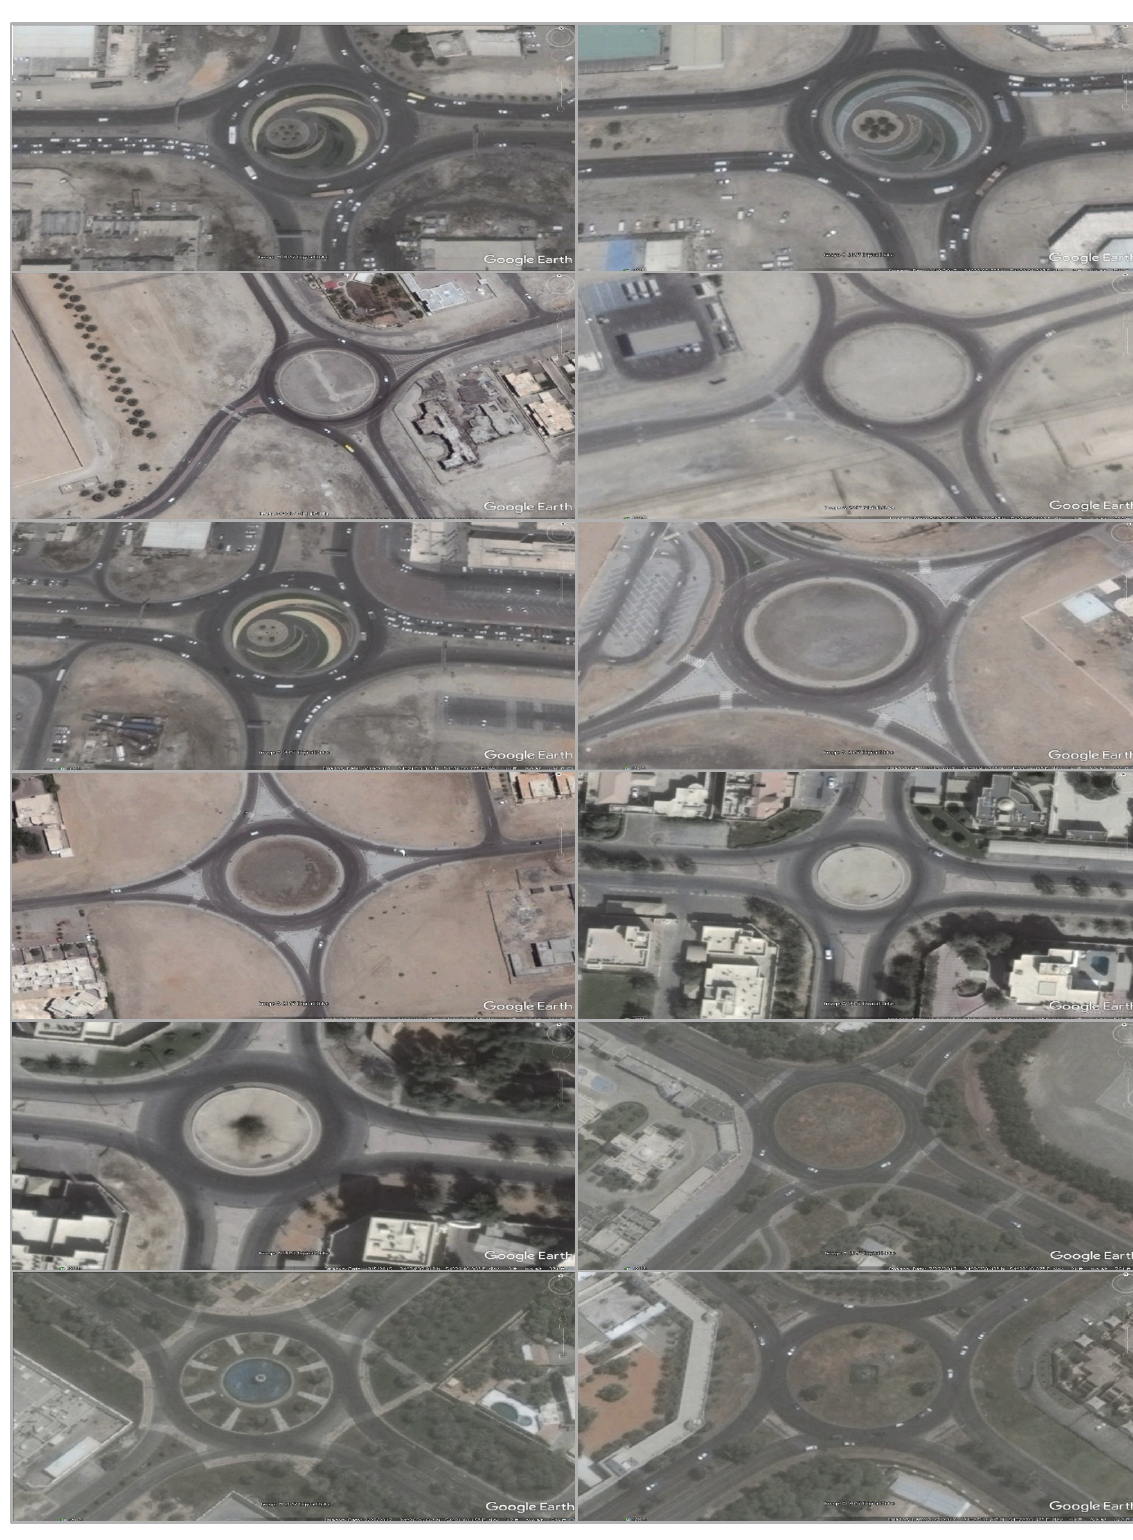
Figure 1: Satellite images of the sites selected for the study (map data ©2018